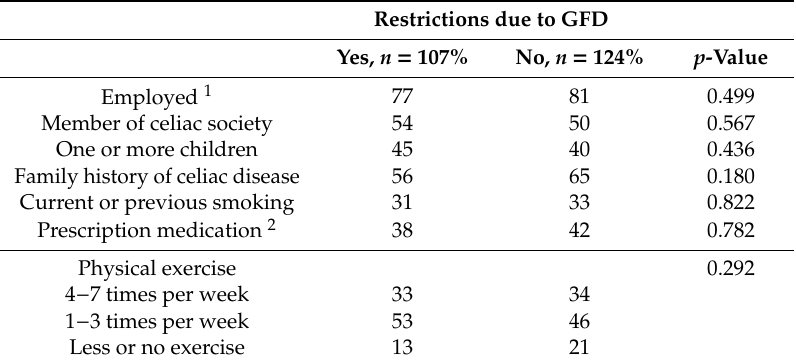
Table 2. Characteristics in 231 adults diagnosed with celiac disease in childhood with and without self-reported restrictions caused by a gluten-free diet (GFD).